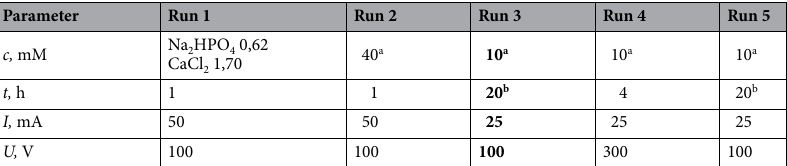
Table 2. Adaption of electrophoretic settings to the IOL polymer until sufficient crystal size for analysis was produced. We started with settings as in Schiraldi et al 22 and physiological concentrations, then successively adapted the settings to the IOL polymer. In order to enable analysis with electron crystallography, a certain crystal size is required, which was best created by parameter settings in run 3 (bold). These settings were set as standard and verified in run 5. Constant parameters in every run were pH 7,40, power 41 W and temperature 22 °C. a Concentration of both CaCl 2 and Na 2 HPO 4 aqueous solutions. b To ensure sufficient ion concentration, the aqueous solutions were changed after 8 h.